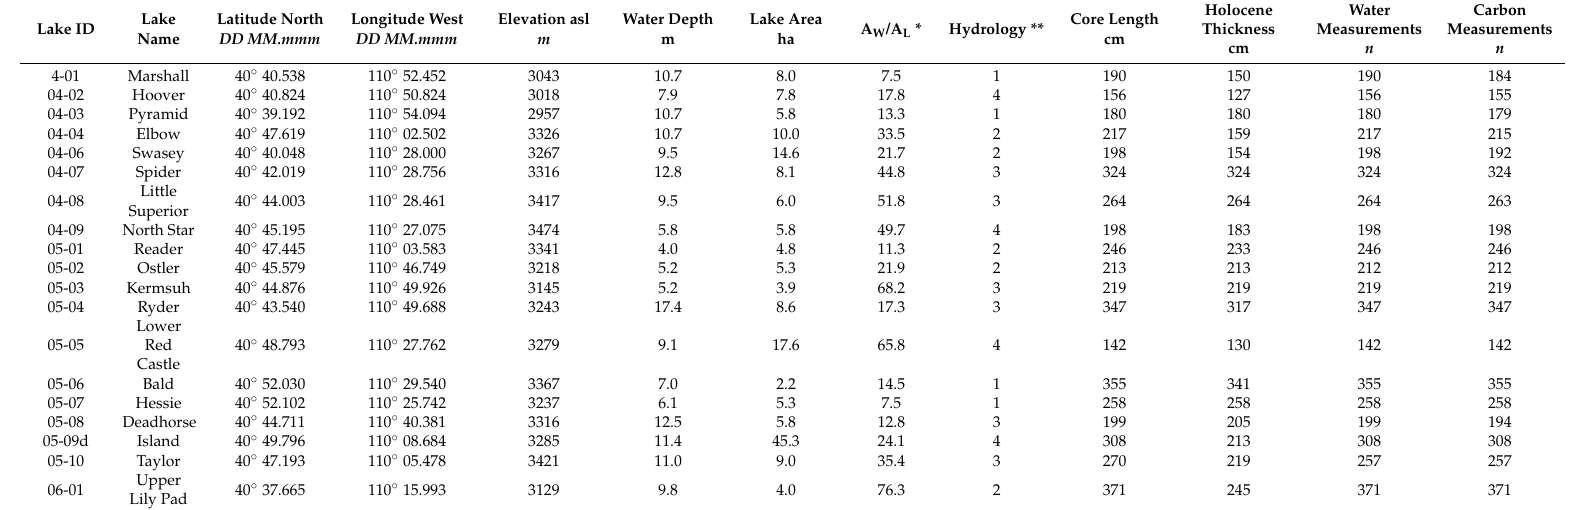
Table 1. Locations and Dimensions of Cored